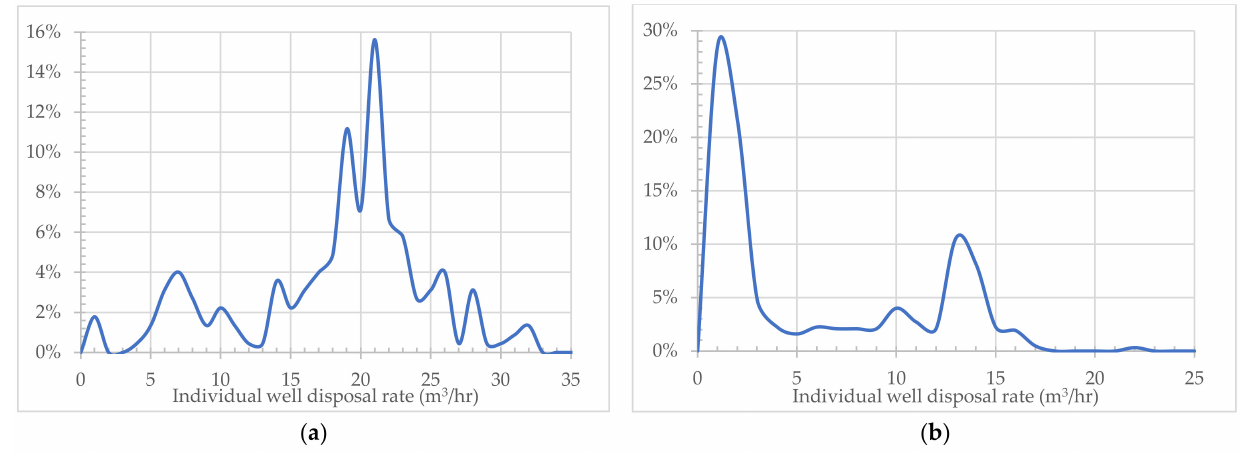
Figure A11. Historical per-well water injection rate ( X -axis) frequency ( Y -axis) distributions (January 1962–December 2022) in ( a ) the Detrital Formation; ( b ) the Spirit River Formation.